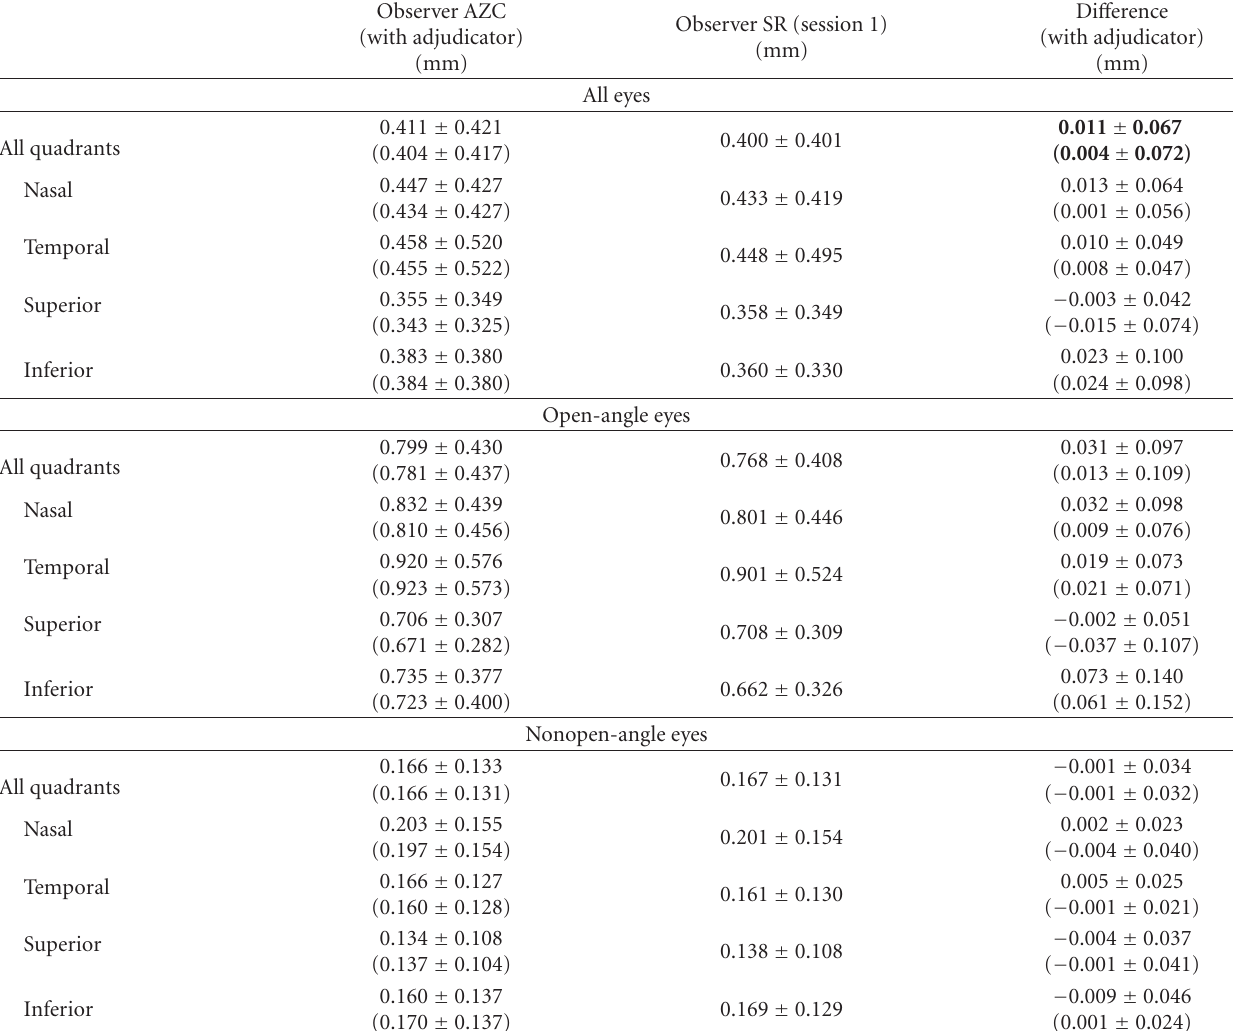
Table 6: Mean ( ± standard deviation) AOD750 (mm) from each observer and their di ff